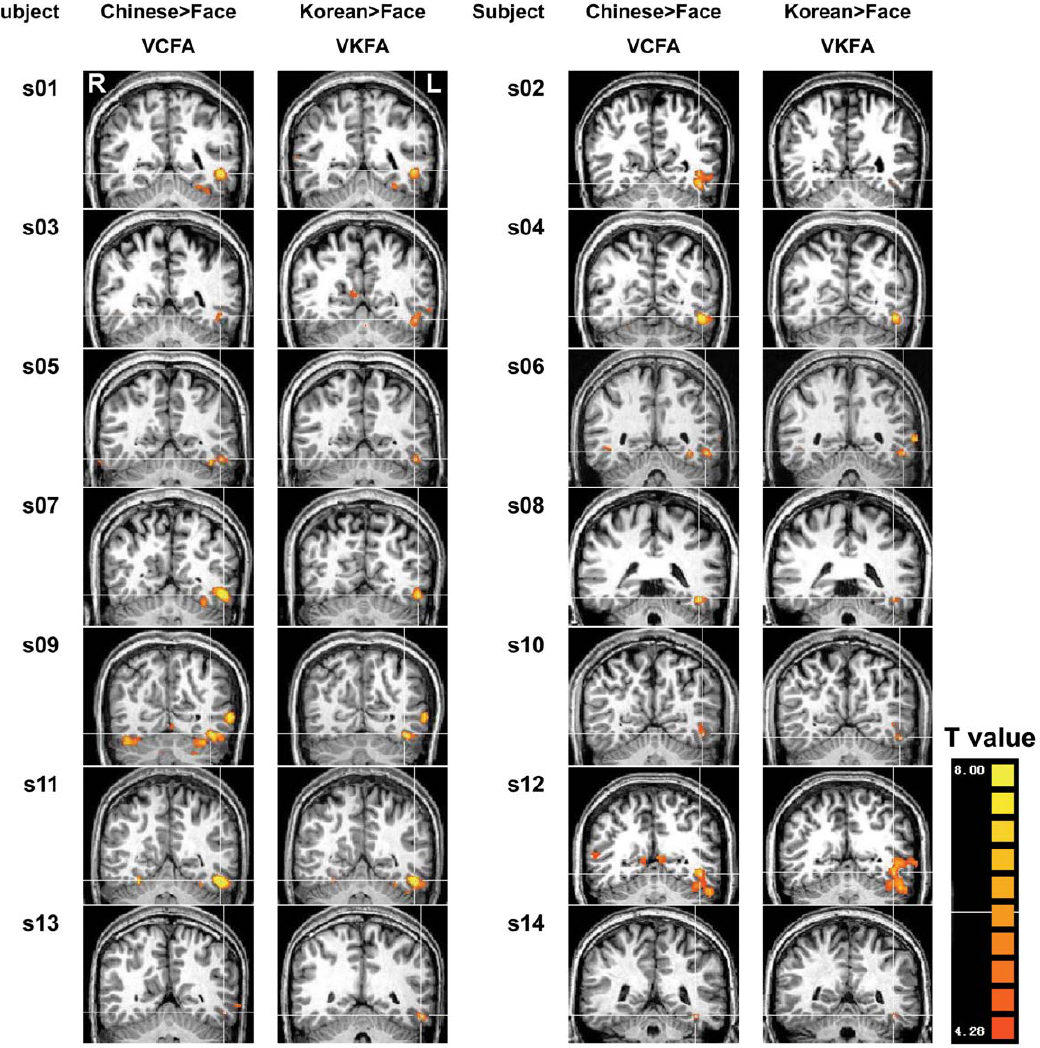
Figure 2. Selectively activated area for Chinese characters and Korean characters in the left occipito-temporal cortex. Brain activation maps in Talairach space of each subject show the activation of Chinese characters and Korean characters when contrasted with faces, respectively (q(FDR) , 10 2 3 ). The right side of the image corresponds to the left hemisphere. The cross in each image is centered at the coordinate for the peak category selective response point. The color bar shows the t values.